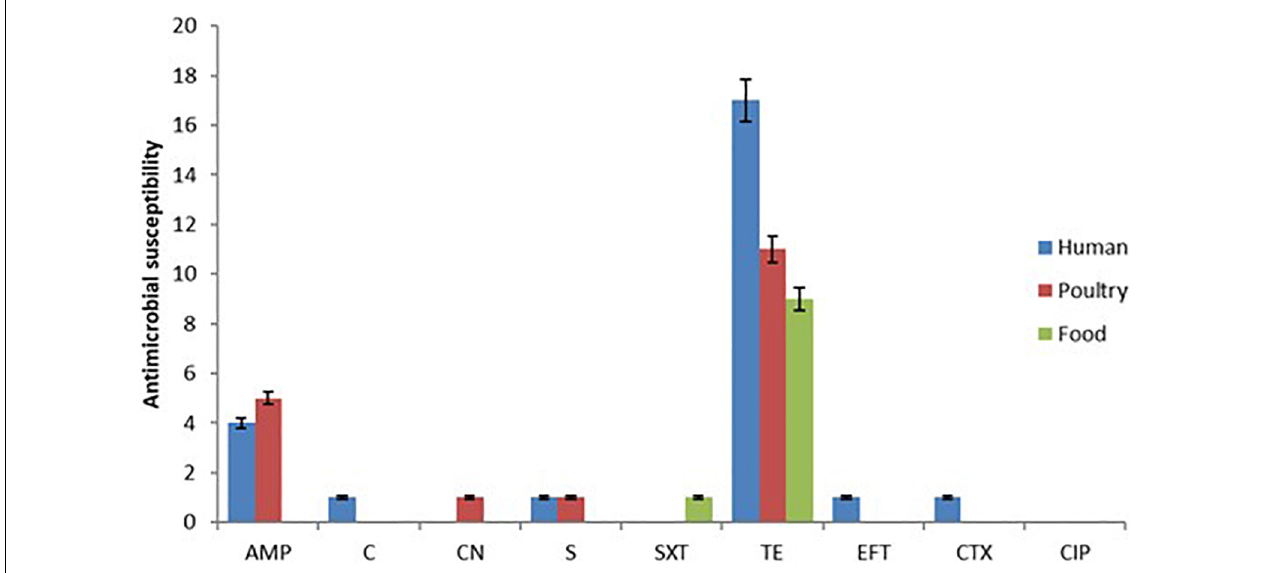
FIGURE 1 | Showing the antimicrobial susceptibility test results based on the Kirby Bauer disk diffusion method indicating high resistance to tetracycline and